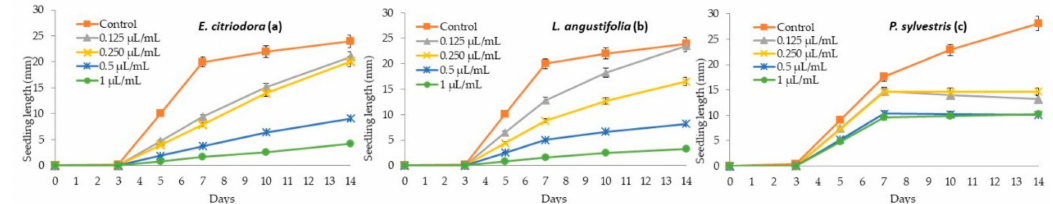
Figure 2. Phytotoxic e ff ect of E. citriodora ( a ), L. angustifolia ( b ), and P. sylvestris ( c ) essential oils at 0.125, 0.25, 0.5, and 1 µ L / mL on the seedling growth (hypocotyl + radicle) of